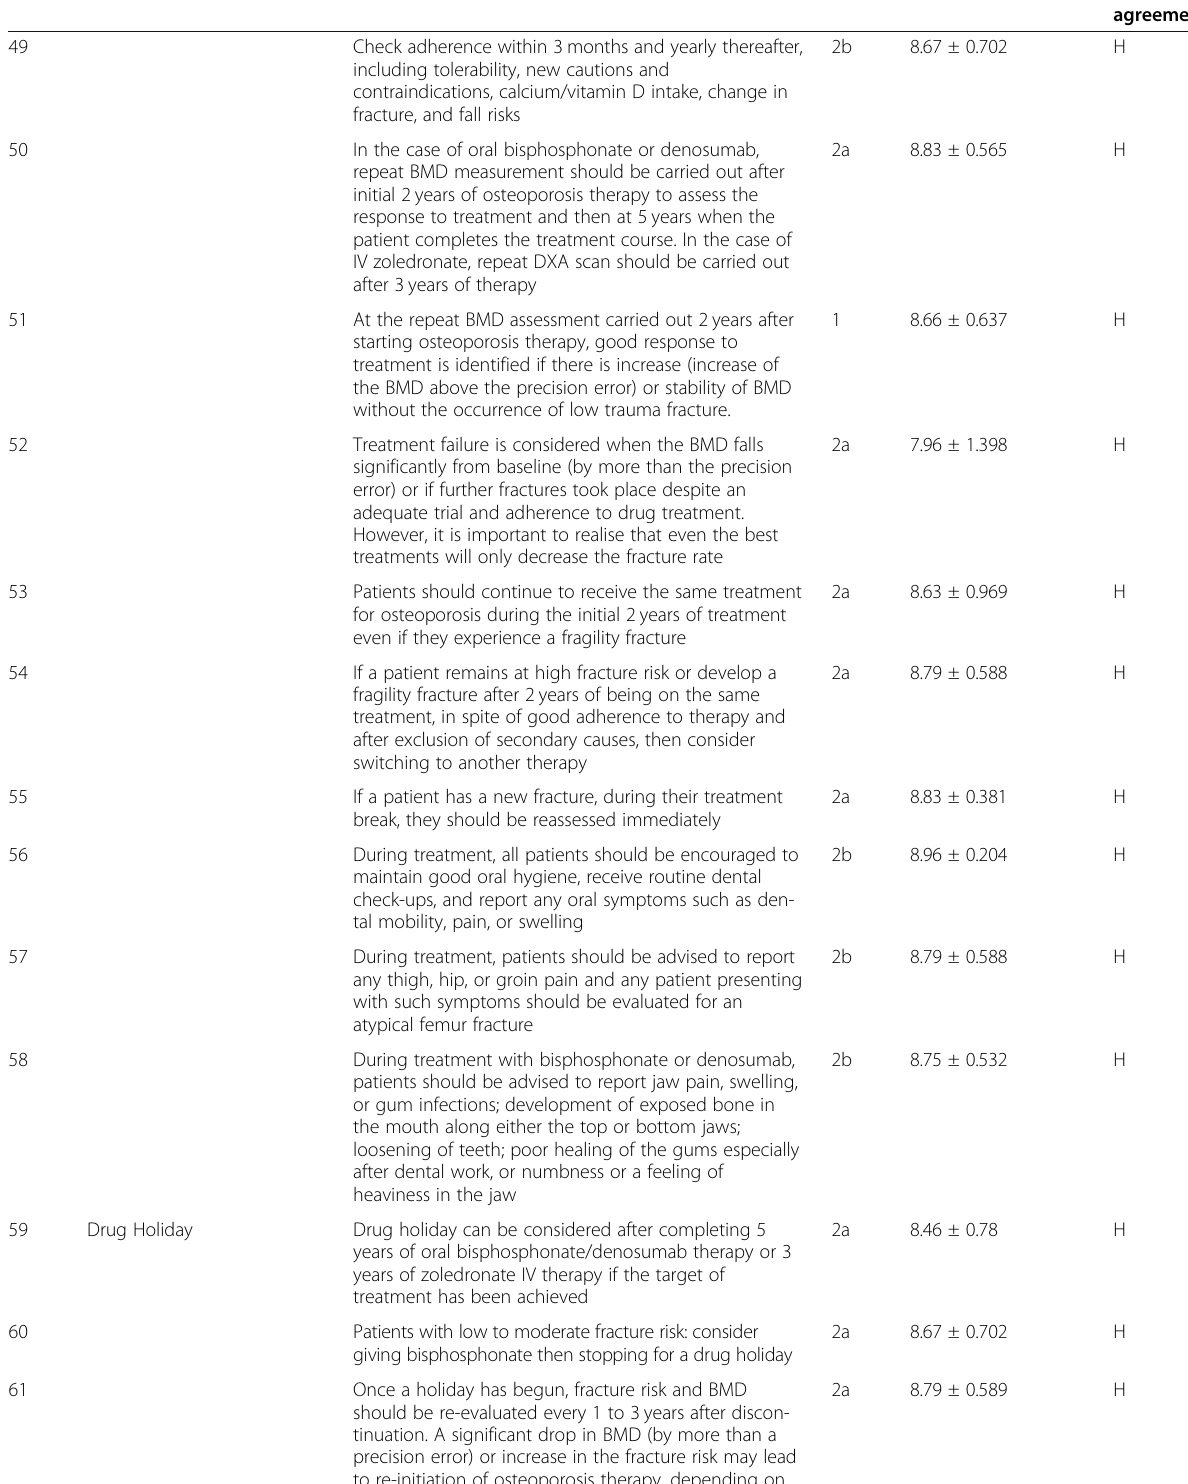
Table 2 Breakdown of statements of recommendations, its individual rank, and level of agreement (Continued)